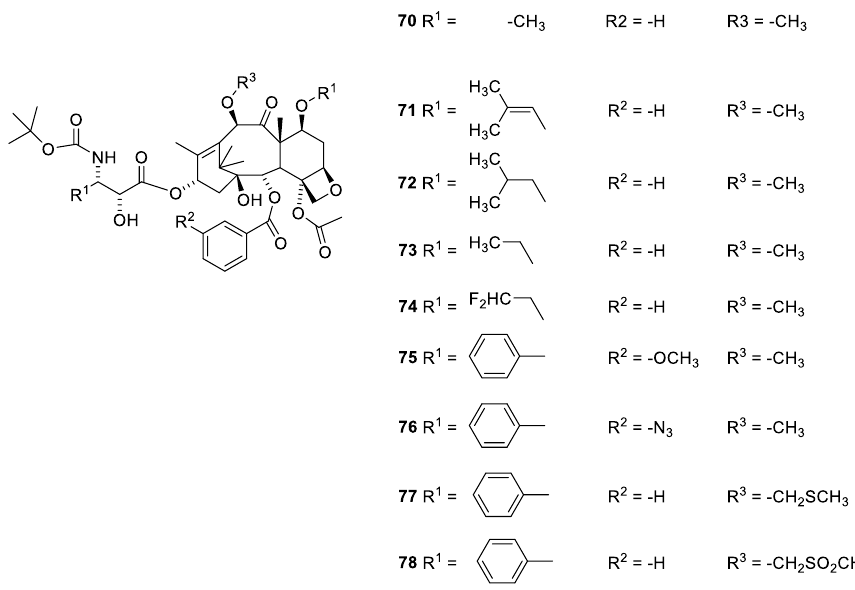
Figure 20. Cabazitaxel ( 70 ) and analogues in which the C- 3′ and the O -9 and O-10 substituents have been varied ( 71 – 78 ) [73].